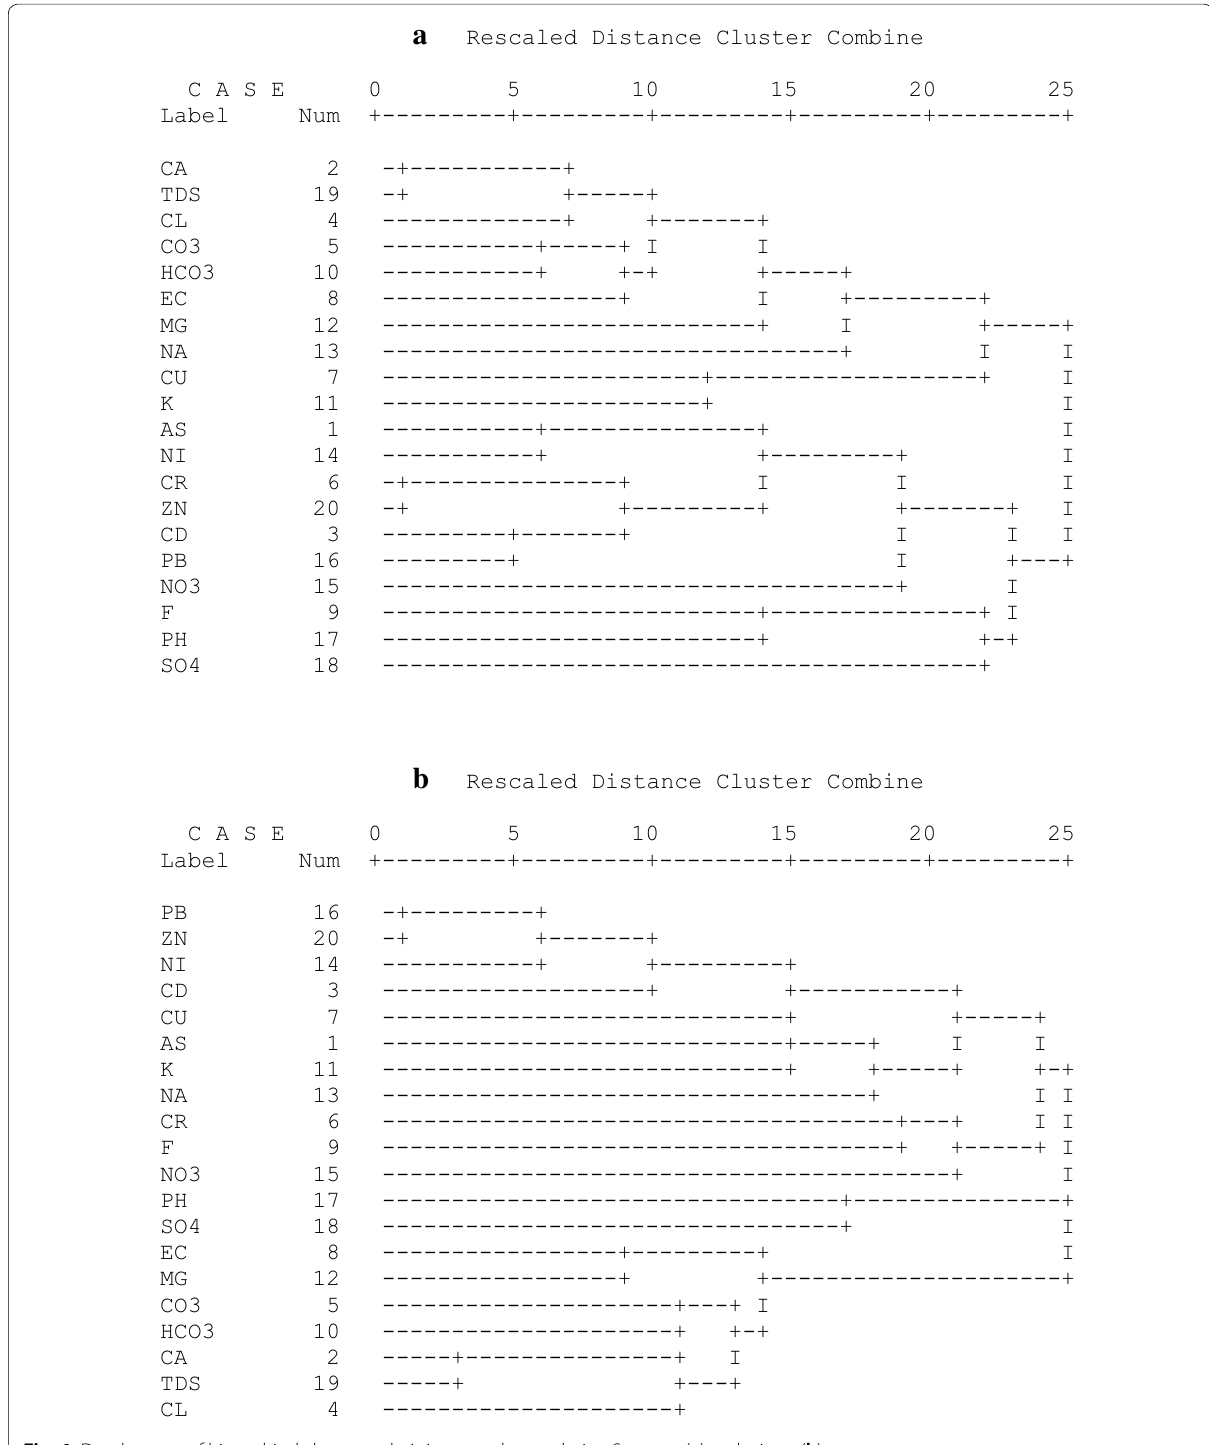
Fig. 4 Dendrogram of hierarchical cluster analysis in groundwater during Summer ( a ) and winter ( b )